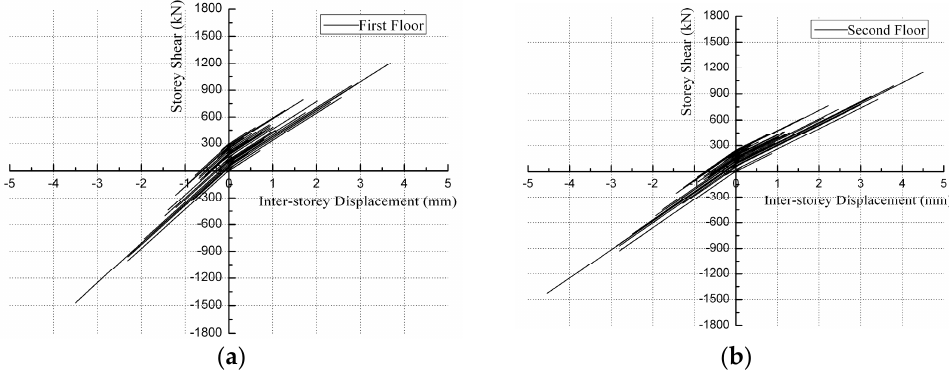
Figure 9. Relationship of the inter-story restoring force and story drift using the non-subdivided integral step for ( a ) the first floor, and ( b ) the second floor.